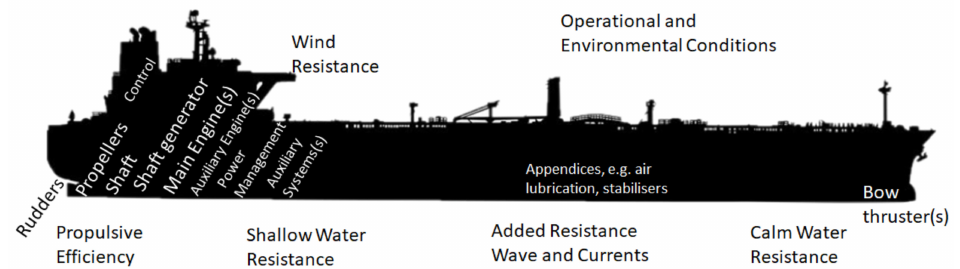
Figure 11. External and internal factors influencing the energy efficiency of ships hydrodynamics and propulsion system.